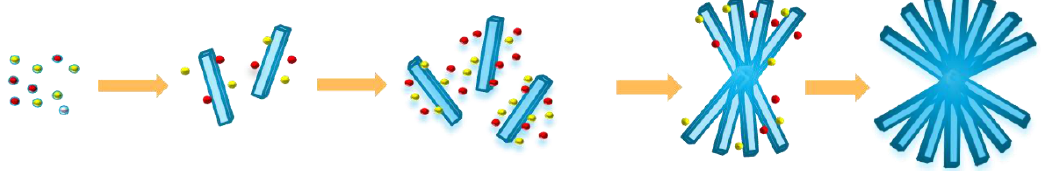
Scheme 1. Schematic illustration for the preparation of CuBi 2 O 4 nanocolumn arrays via the short-time hydrothermal synthesis.